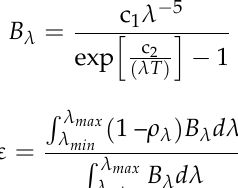
Figure S6: Cyclic stability of the ECD with NiO measured at ± 3 V with a duration of 60 s, Table S1: Comparison of the W-NiO film and ECD with previously reported